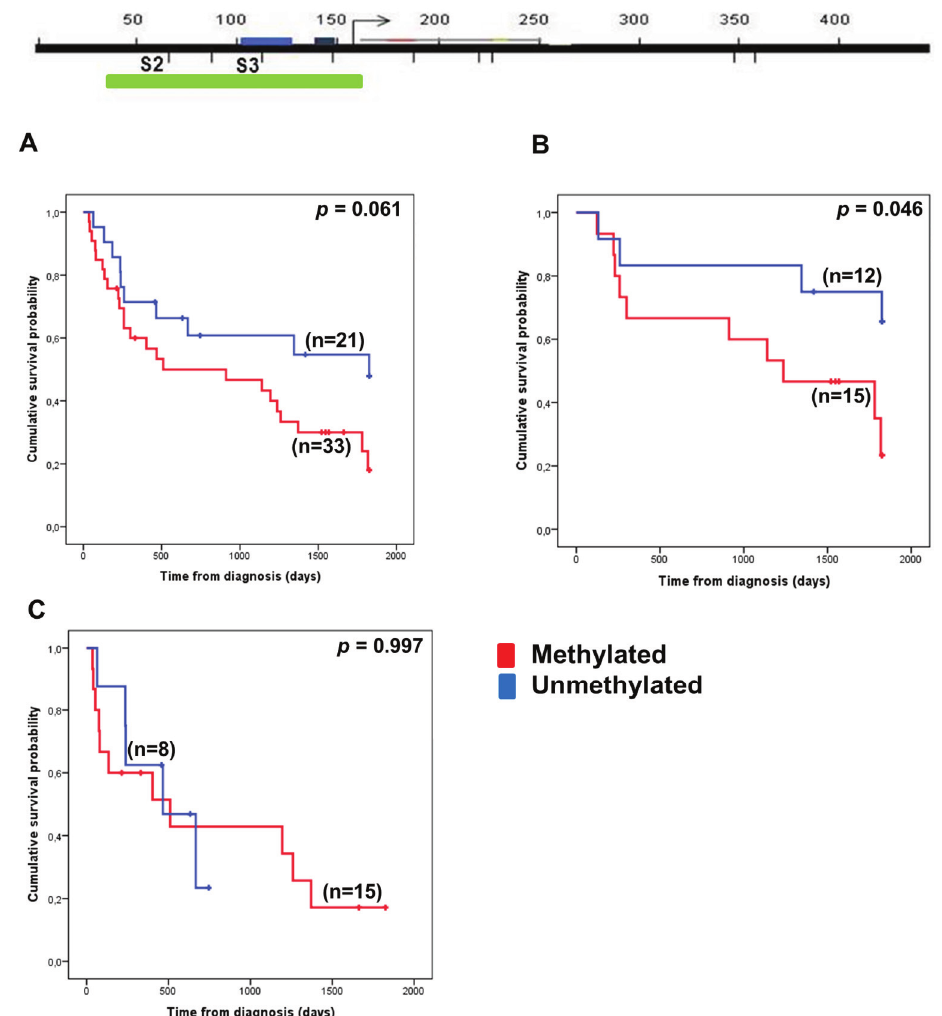
Figure 3. Methylation status of the VTRNA1-3 promoter associates only with 5-year overall survival in the lower risk MDS patient subgroup. Hypermethylation of VTRNA1-3 was defined as the occurrence of mean methylation levels (cid:2) 20% as determined by pyrosequencing. The top panel indicates the region analyzed by pyrosequencing (green box) relative to the TSS and the Ms-SNuPE primers used in the previous analyses (promoter elements are indicated by blue boxes). 5-Year overall survival according to VTRNA1-3 methylation in ( A ) all MDS patients; ( B ) lower risk (LR and INT-1) patients; and ( C ) higher risk (INT-2 and HR) patients. A break in the line indicates a censored